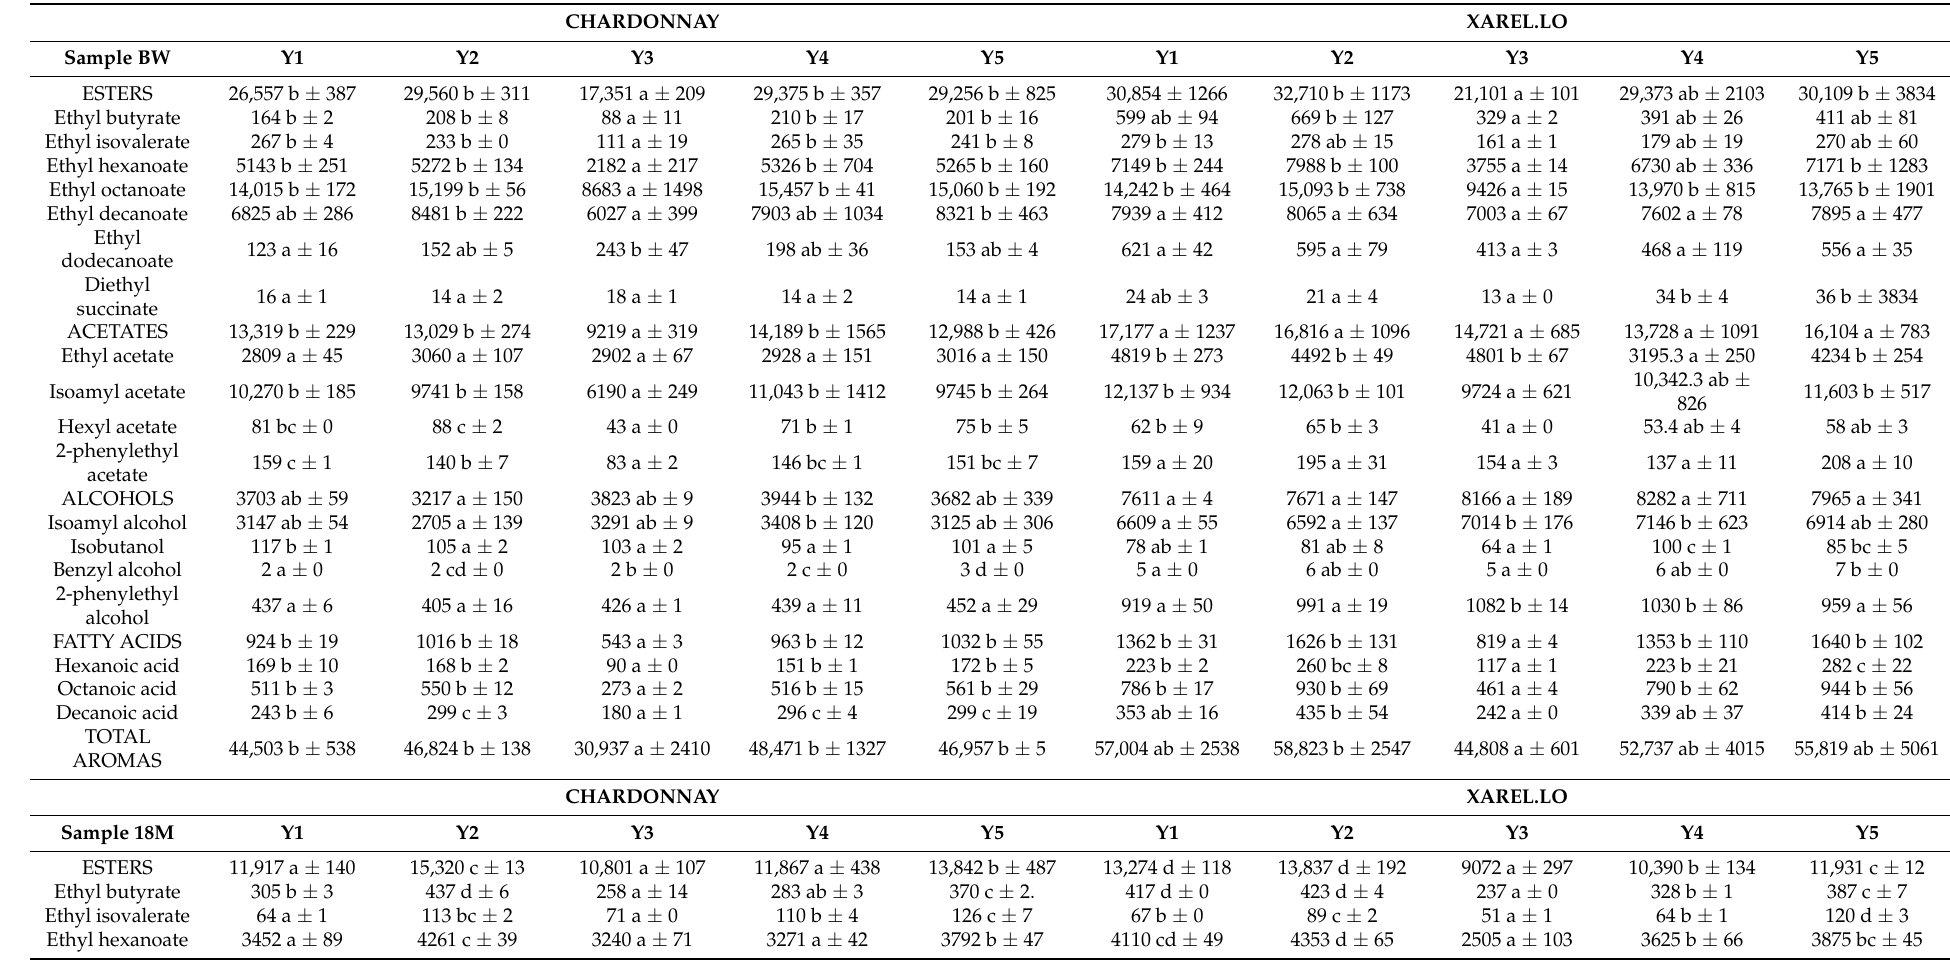
Table 3. Families of volatile compounds ( µ g/L) from Chardonnay and Xarel.lo base wines (BW) and cavas, after 18 months of aging on the lees (18M), with the addition of five different yeasts in the alcoholic fermentation (Y1, Y2, Y3, Y4, Y5). Different letters indicate significant differences between samples with different yeasts for each grape variety, and in each of the analysis times. Samples (n =